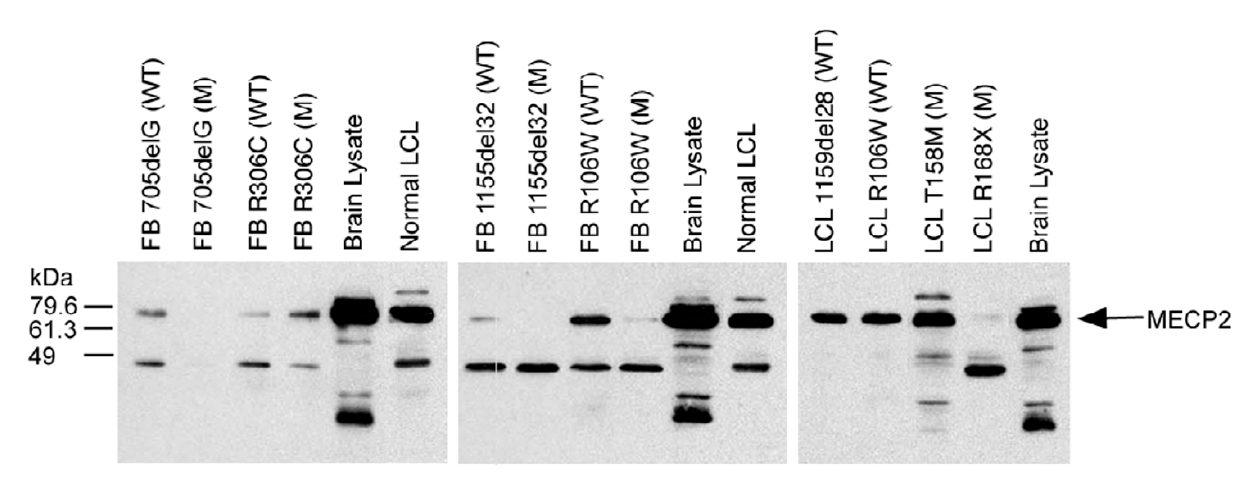
Figure 2 Immunoblots of total cell lysates from wild-type (WT) and mutant (M) fibroblast clones and lymphoblastoid cell lines used for the oligonucleotide expression array hybridization studies. MeCP2 expression is detected with a C-terminal antibody; the molecular weight of MeCP2 is shown as 75 kDa, consistent with the company's information [http://www.upstate.com]. In mutant cell lines with nonsense mutations (FB 705delG, FB 1155del32, and LCL R168X), an intact MECP2 protein is not seen. Brain lysate from mice and normal human male lymphoblastoid cells serve as positive